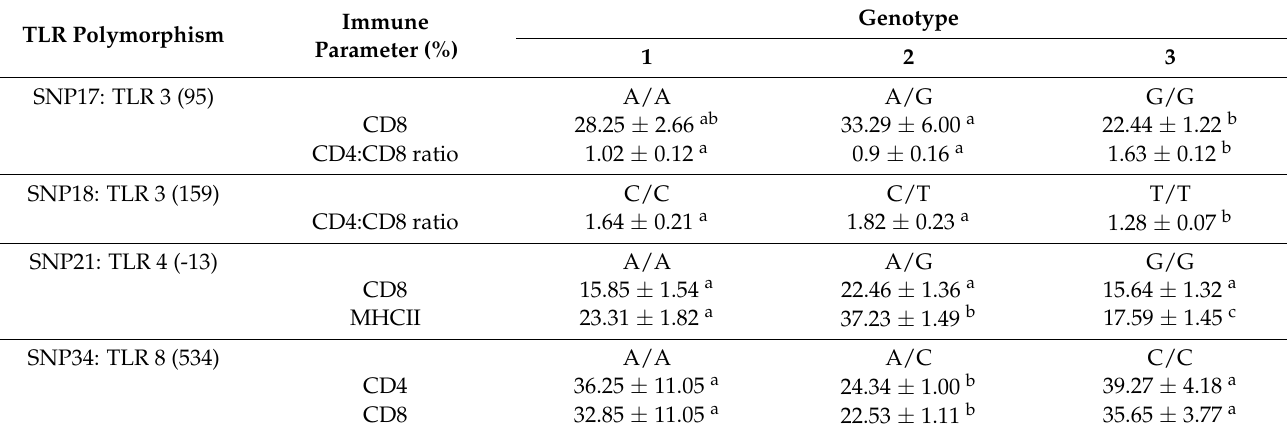
Table 7. Effects of SNPs in Toll-like receptor genes on the expressions of immunity parameters in pig